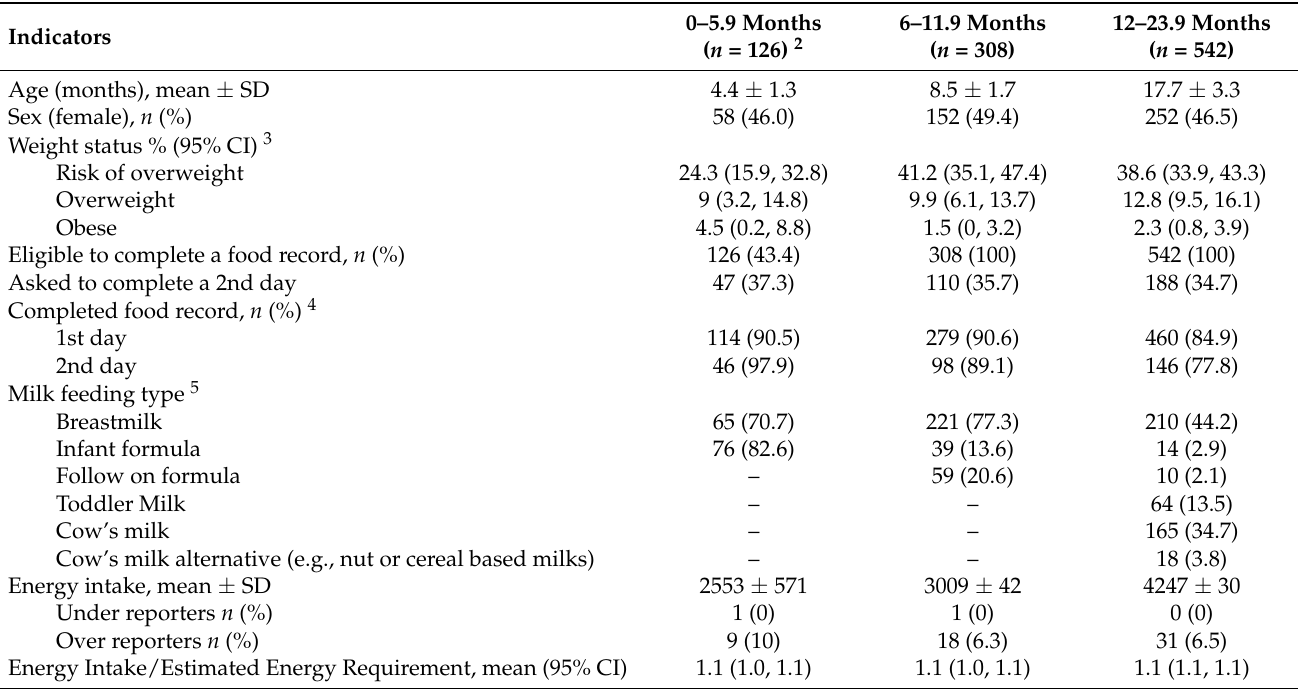
Table 1. Characteristics of children enrolled in OzFITS 2021 eligible for food records ( n = 976) 1